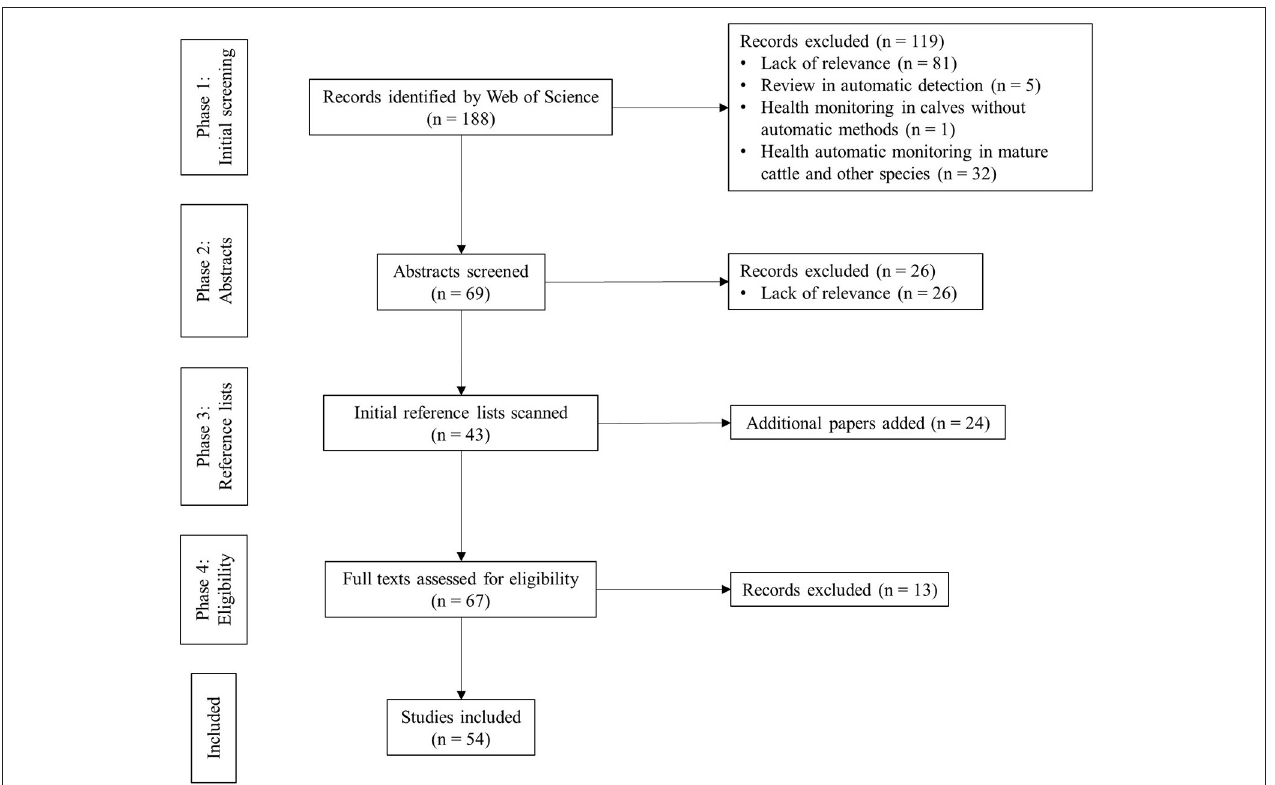
FIGURE 2 | Article selection